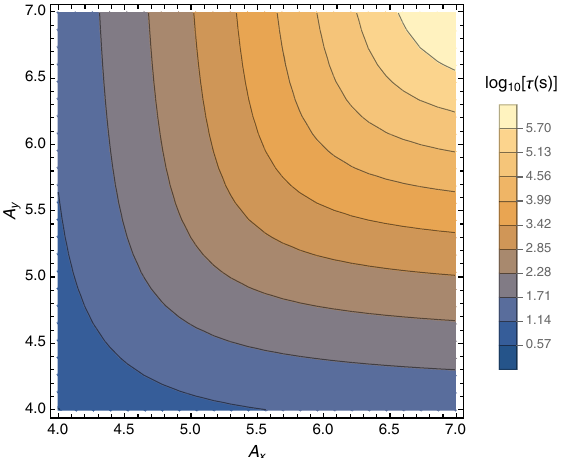
FIG. 7. The dependency of the quantum lifetime on the horizontal and vertical apertures with A p ¼ 8 . 8 . ( λ x = λ y = λ p ¼ 5 . 2 = 5 . 0 = 5 . 5 s − 1